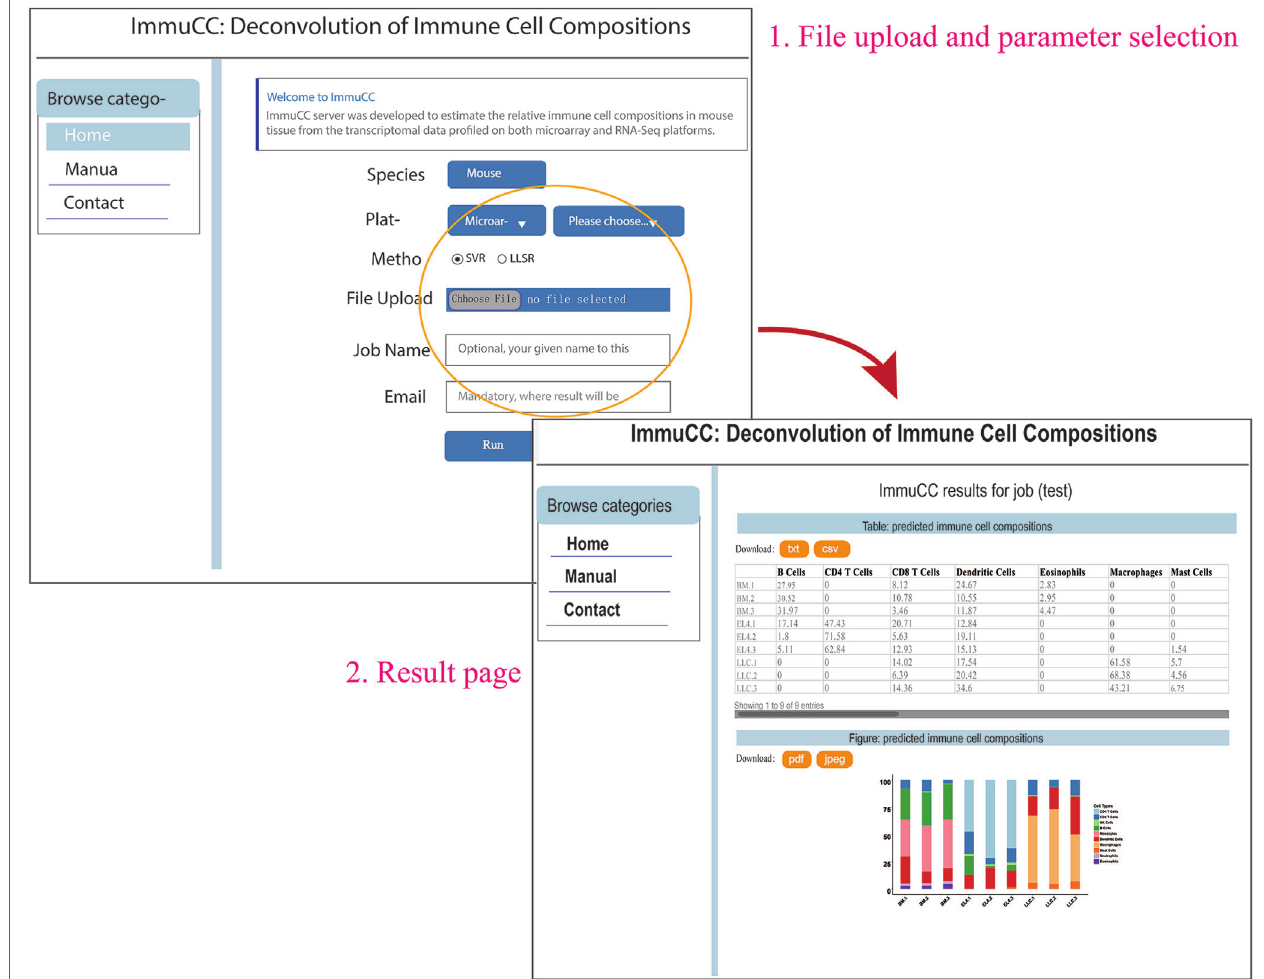
FIGURe 6 | Online webserver for the deconvolution of immune cell compositions in mouse tissues. The webserver is available at